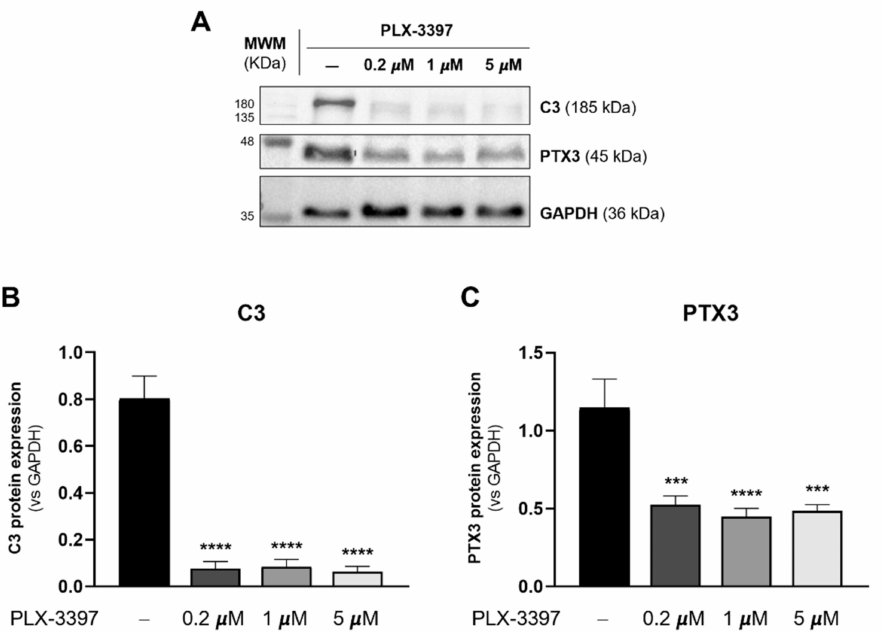
Figure 5. PLX-3397 decreases the reactivity of cultured astrocytes. ( A ) Representative immunoblots of C3, PTX3 and GAPDH with no exposure ( − ) and exposure to 0.2 µ m, 1 µ m and 5 µ M of PLX-3397. Densitometric analysis of ( B ) C3 and ( C ) PTX3 was performed with ImageJ software using GAPDH as loading control. All values are mean ± SEM. N = 4 independent experiments. Statistical analysis was performed with one-way ANOVA followed by Dunnett’s multiple comparison test, *** p < 0.001, **** p < 0.0001 in comparison with control